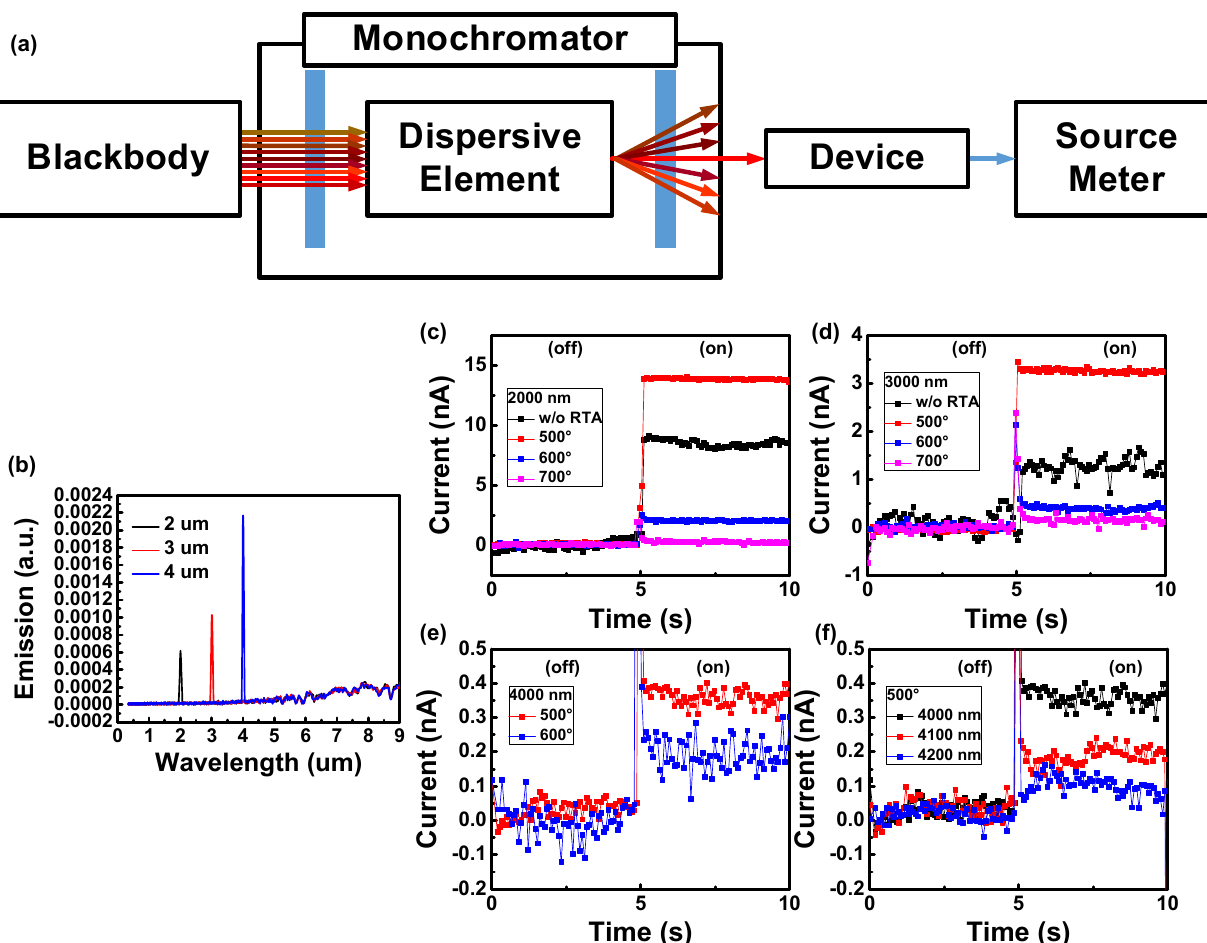
Figure 2. ( a ) Measurement setup with monochromator. ( b ) Spectroscopic results for the 2, 3, and 4 μm monochromator settings. ( c – f ) Current variation over time of each thermal annealing parameter device under 2 μm, 3 μm, and 4 μm. ( f ) After annealing at 500 °C, the behaviors of the device under 4, 4.1, and 4.2 μm light irradiation.